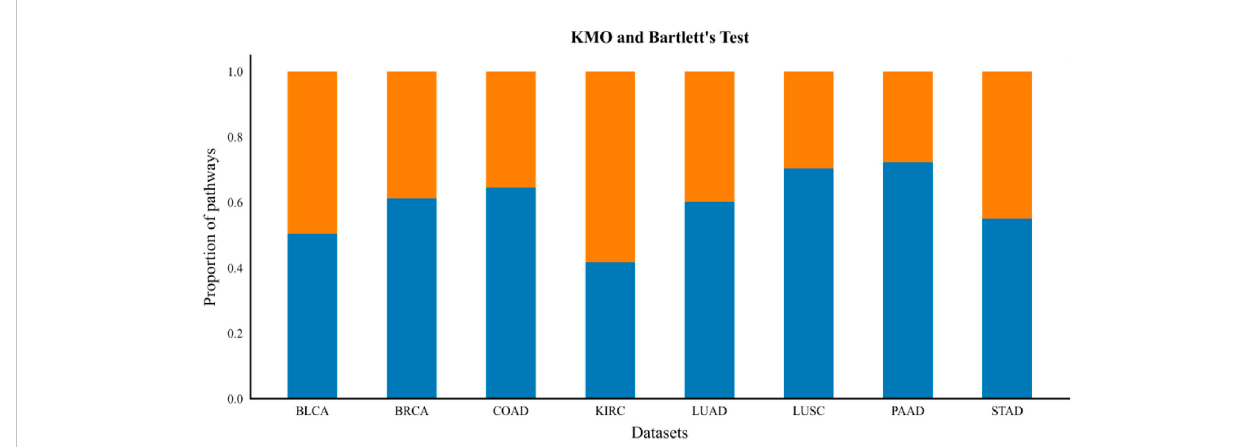
FIGURE 4 KMO and Bartlett ’ s test. The blue bars below the fi gure indicate the proportion of gene expression pro fi les of GO Term suitable for factor analysis after the KMO test and Bartlett ‘ s test of sphericity.